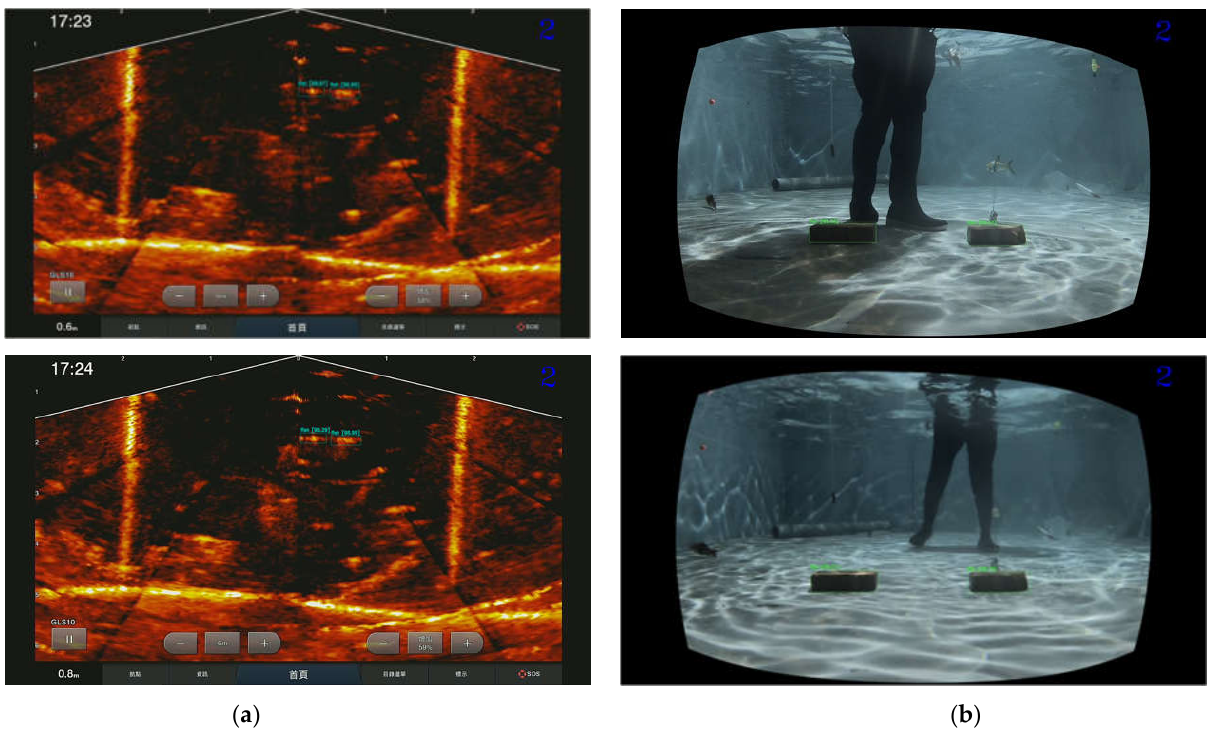
Figure 18. Detection results (marker) of the target object from ( a ) sonar and ( b ) stereo images.